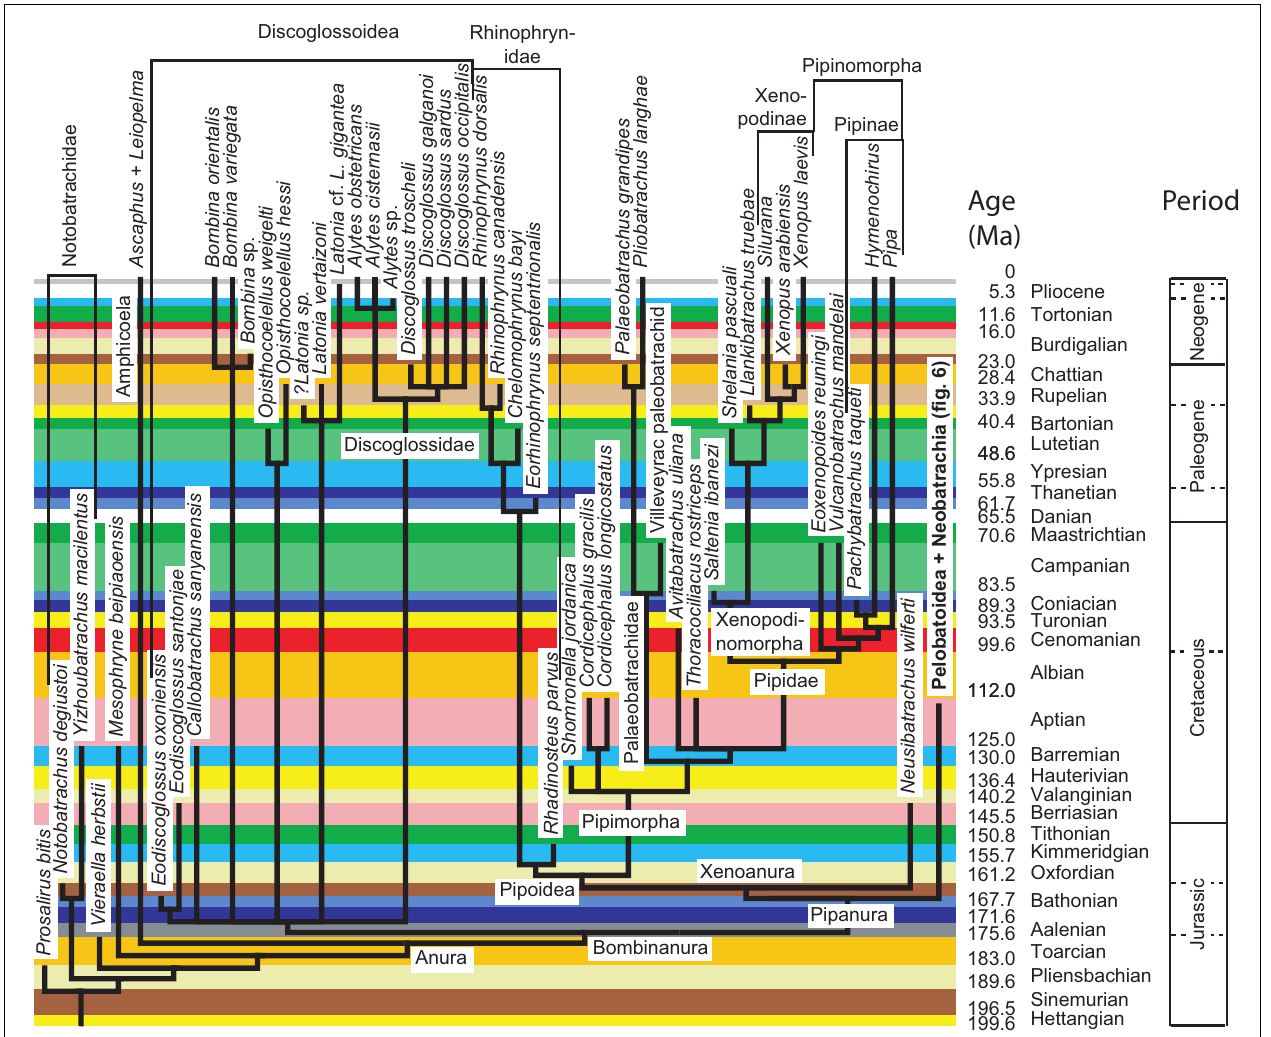
FIGURE 2 | Part of the time-calibrated supertree of lissamphibians presented by Marjanovi´c and Laurin (2007). Modified from Marjanovi´c and Laurin (2007: Figure